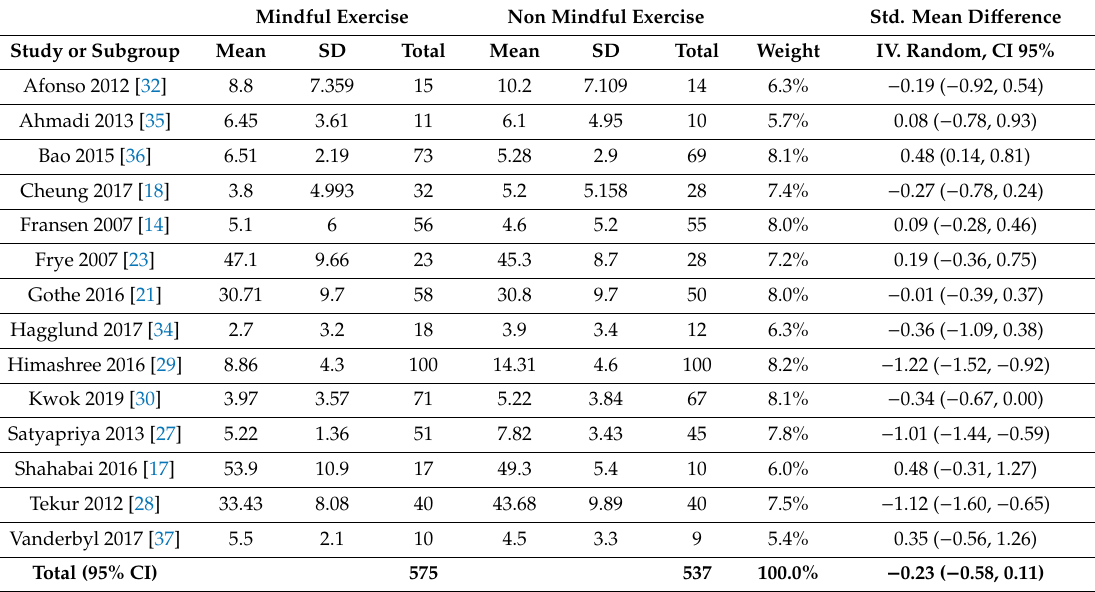
Table 2. E ff ect of mindful exercise on anxiety symptoms in comparison to non-mindful exercise. Mindful Exercise